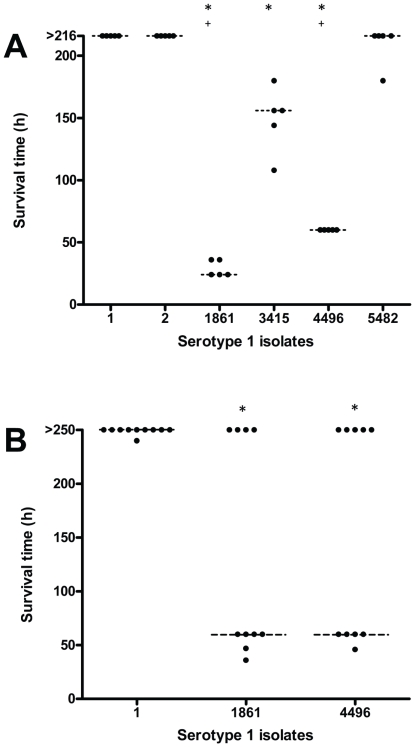
Confirmation of virulence in mice of non-invasive and invasive serotype 1 isolates.Survival times were recorded following i.p. (A) or i.n. (B) challenge with approximately 104 CFU and 107 CFU of the relevant strain, respectively. Experiments were undertaken for 216 h and 252 h following i.p. and i.n. challenge, respectively. Horizontal broken lines indicate the median survival time. Statistical significance was calculated using the two-tailed Mann-Whitney U test. (*, +, P<0.05). ‘*’ indicates comparison with non-invasive isolates; ‘+’ indicates comparison with intermediately virulent isolates.